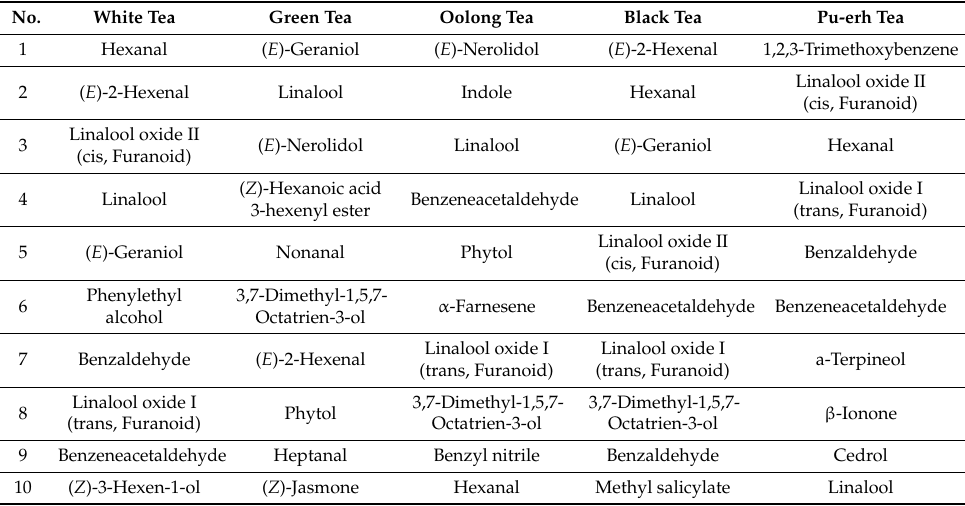
Table 1. Top ten volatiles in various types of tea [27] 1